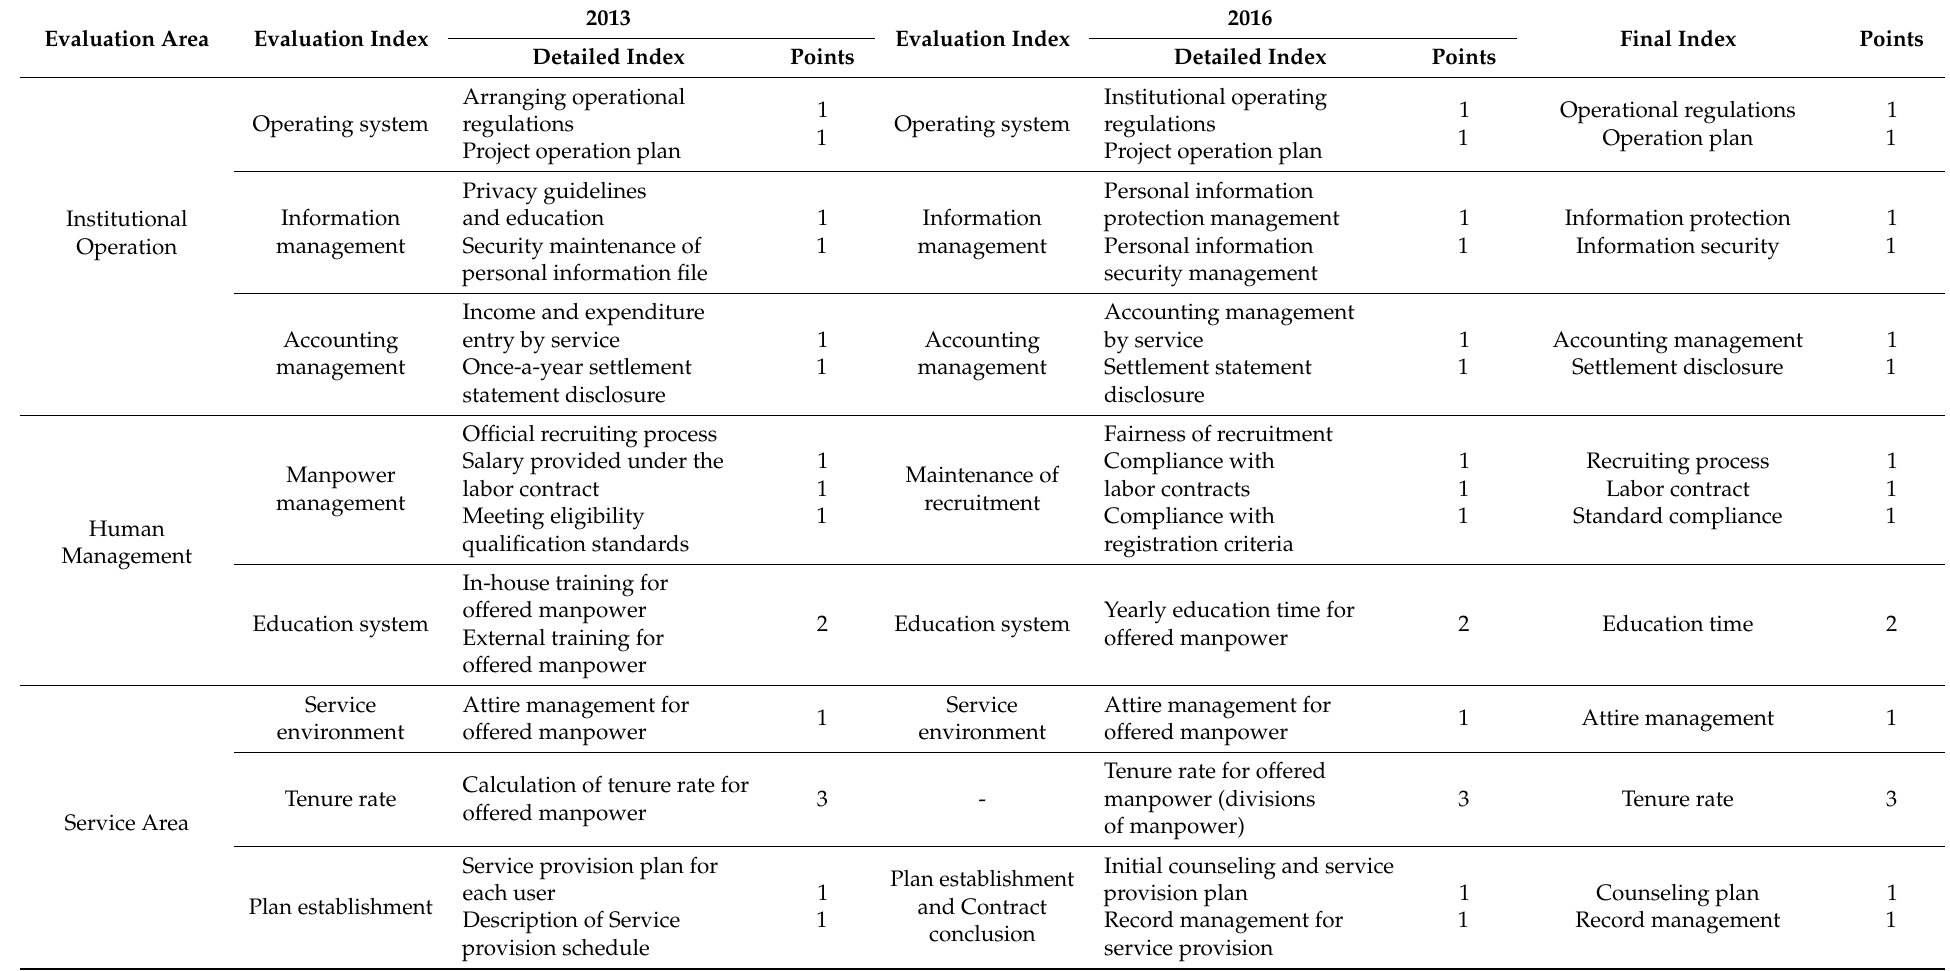
Table 1. Common indexes for care service QE (Quality